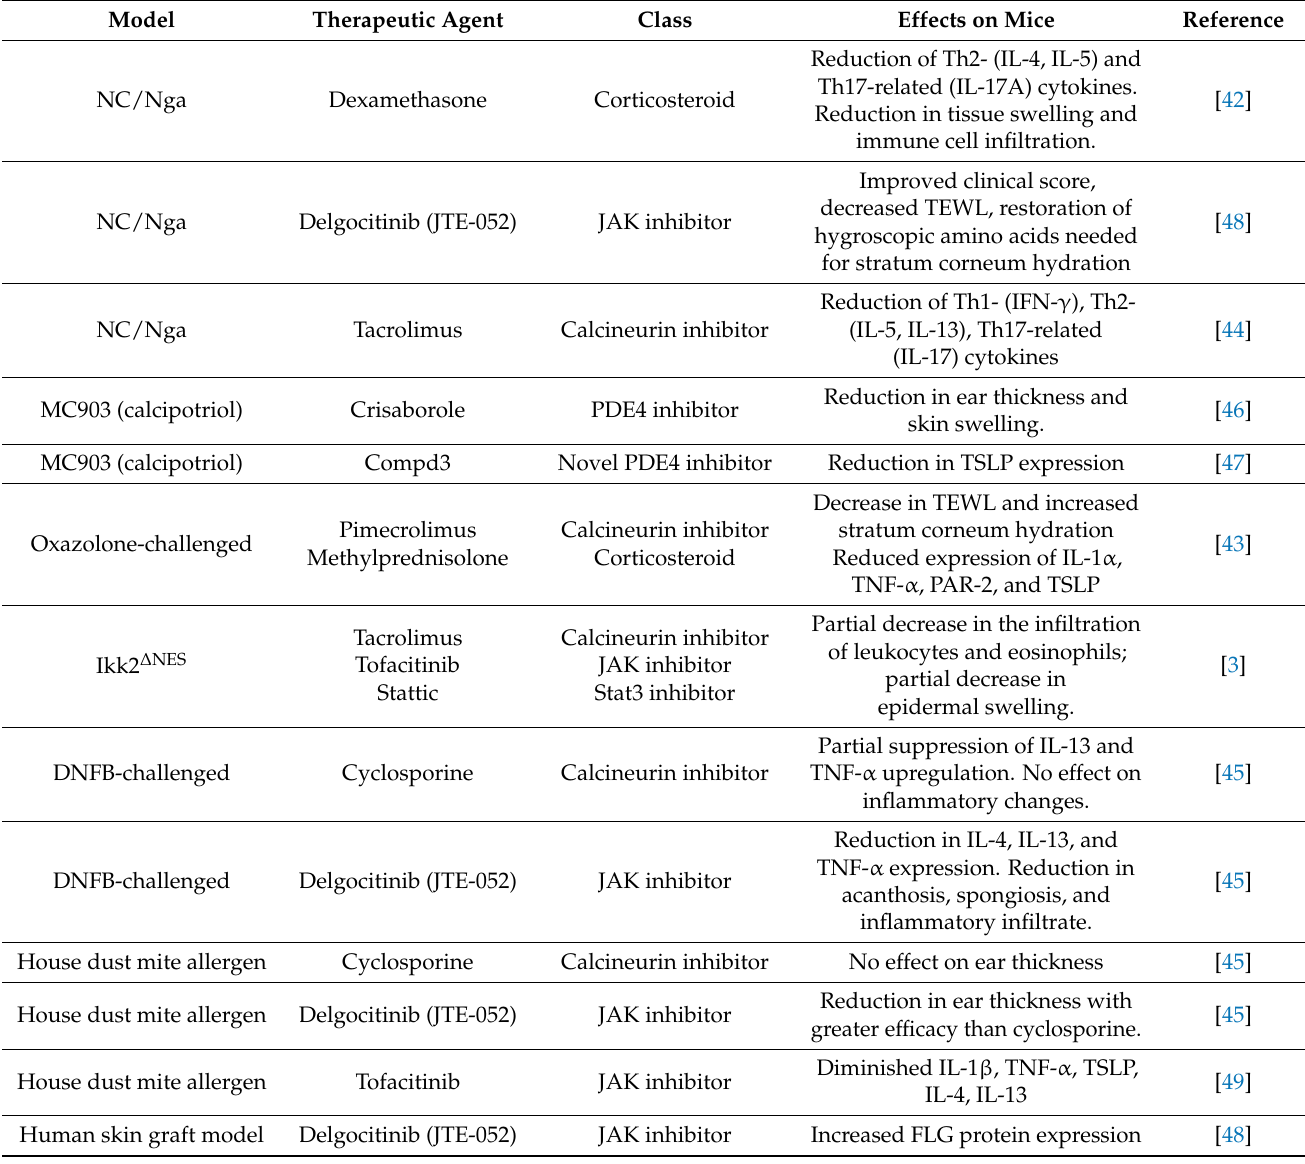
Table 4. The effect of select FDA-approved or investigational agents on specific